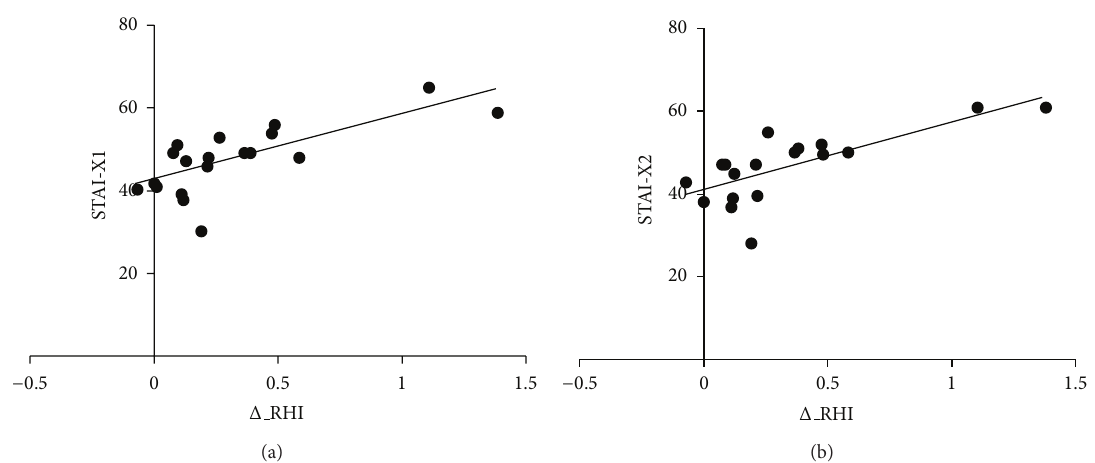
Figure 6: Linear ralationship between state anxiety (Stai-Xl) and trait anxiety (Stai-X2) questionnaire scores and delta RHI